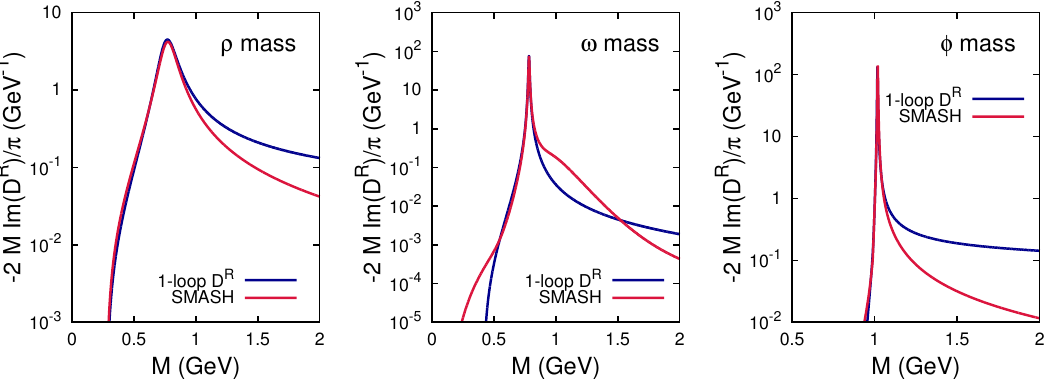
Figure 1. Spectral functions of the ρ meson ( left ), ω meson ( center ) and φ meson ( right ). Spectral functions from the retarded propagator, which is used in a dilepton study [21], are compared to the parametrization from Ref. [22], which is used in SMASH